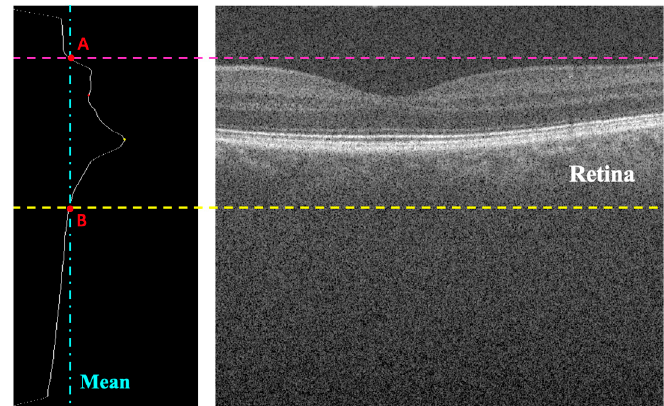
Figure 3. The result of the ROI.